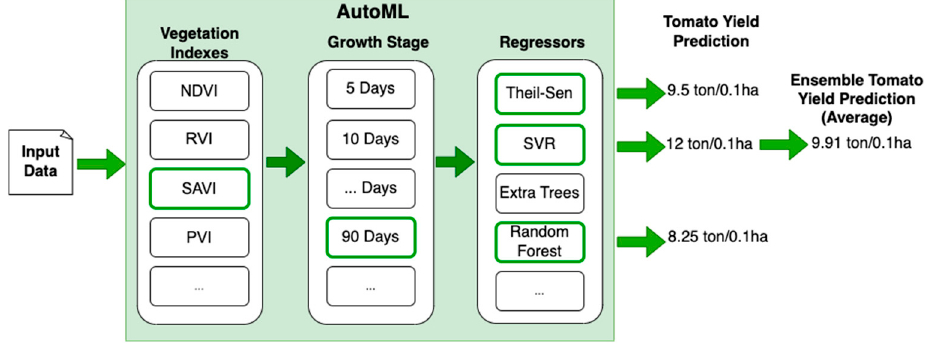
Figure 4. The use of AutoML for selection of the best combination of inputs (vegetation index and growth stage) and creating an ensemble of regression models is proposed as the methodology.